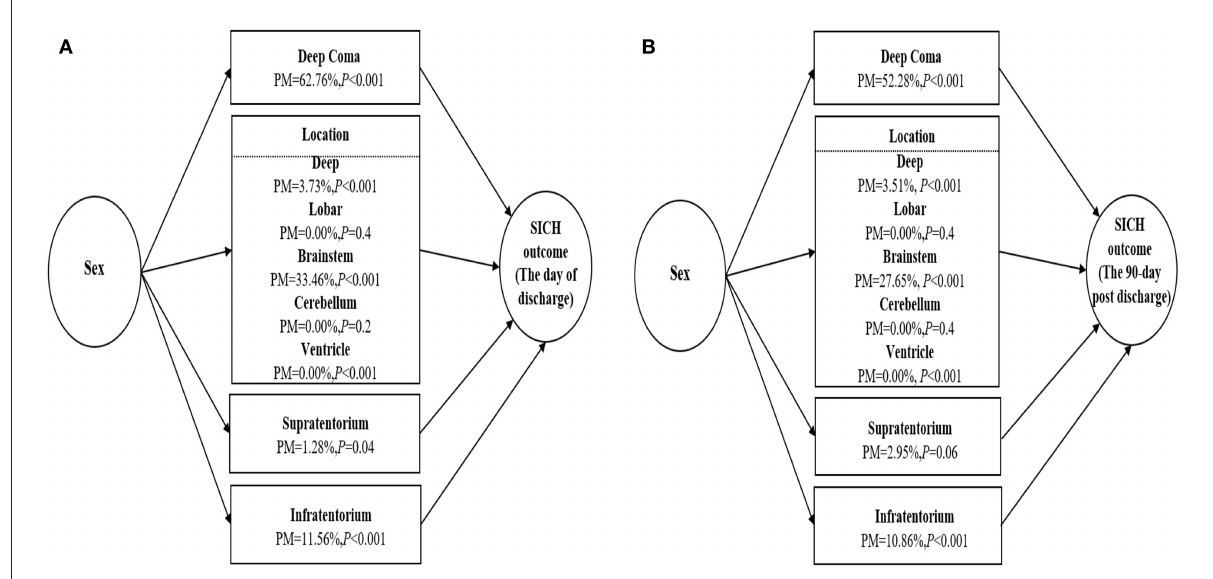
FIGURE1 (A) Causal mediation analysis for sex association with spontaneous intracerebral hemorrhage (SICH) outcome on the day of discharge. (B) Causal mediation analysis for sex association with SICH outcome at the 90-day post-discharge. PM, proportion